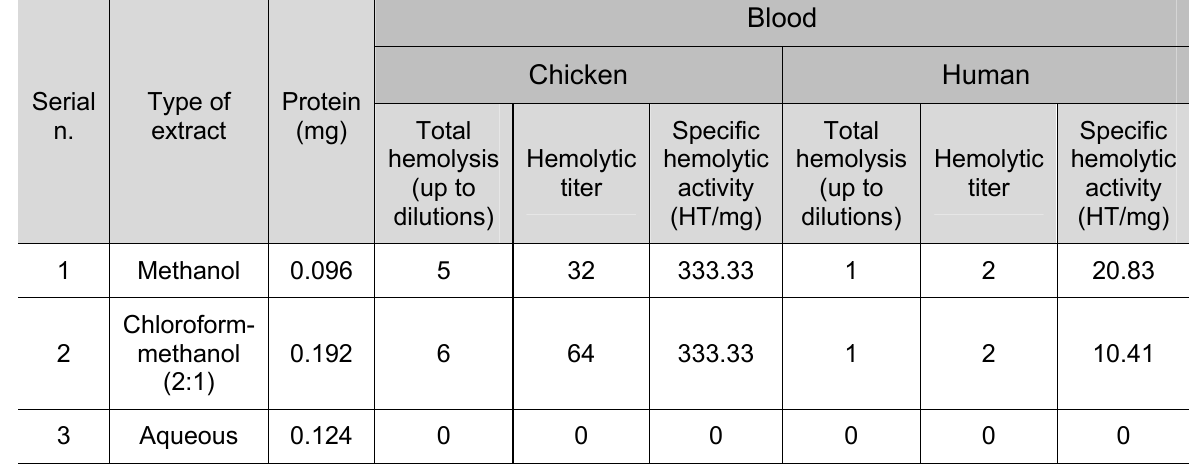
Table 1. Hemolytic activity of Halichondria panicea crude toxin at 5 mg/mL in chicken and human erythrocytes Serial